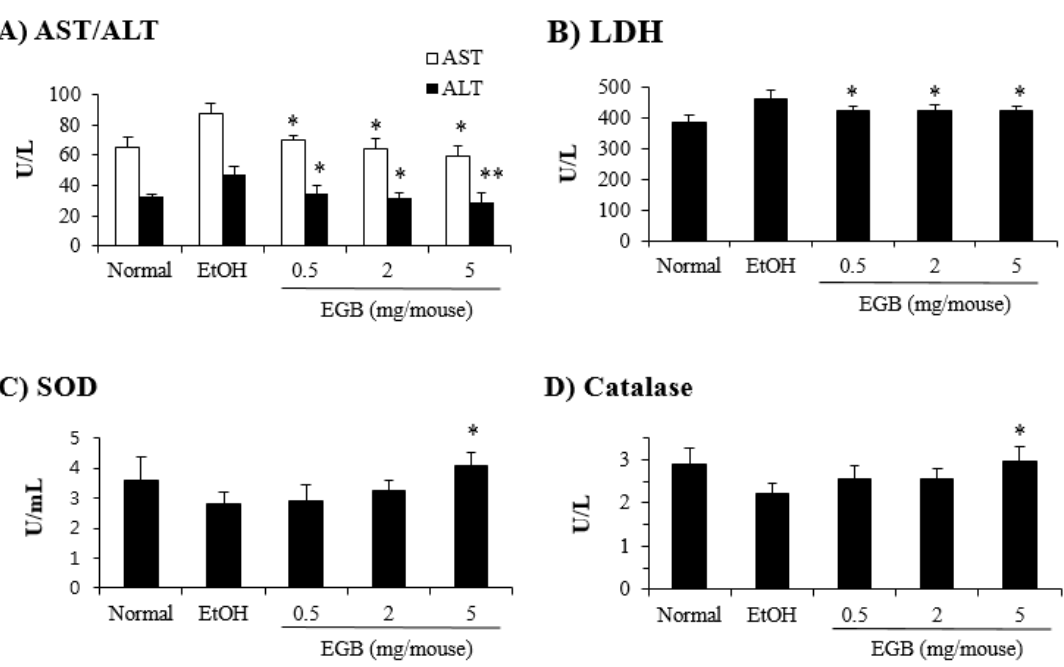
Figure 6. Dose-dependent effect of EGB on the expression of AILD-related enzymes. Mice were administered p.o. with the indicated doses of EGB, and the levels of liver profile enzymes, AST/ALT ( A ) and LDH ( B ) in the serum specimens and antioxidant enzymes such as SOD ( C ) and catalase ( D ) in the liver tissues were determined 1 day after the final administration of EtOH. * p < 0.05, ** p < 0.01, compared with the EtOH-fed group.